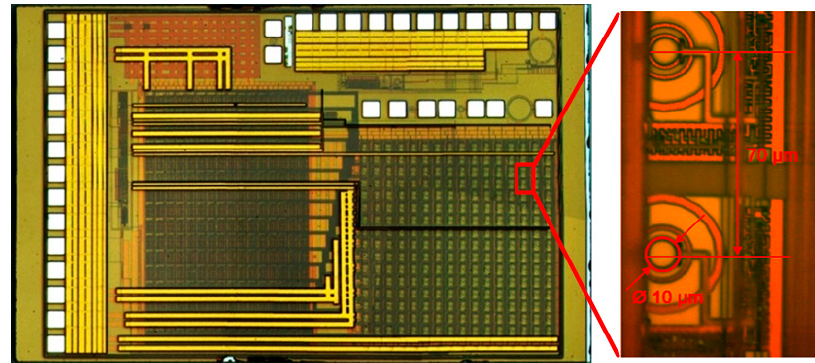
Figure 5. CMOS SPAD camera with a detail of the 10 µm circular pixels.